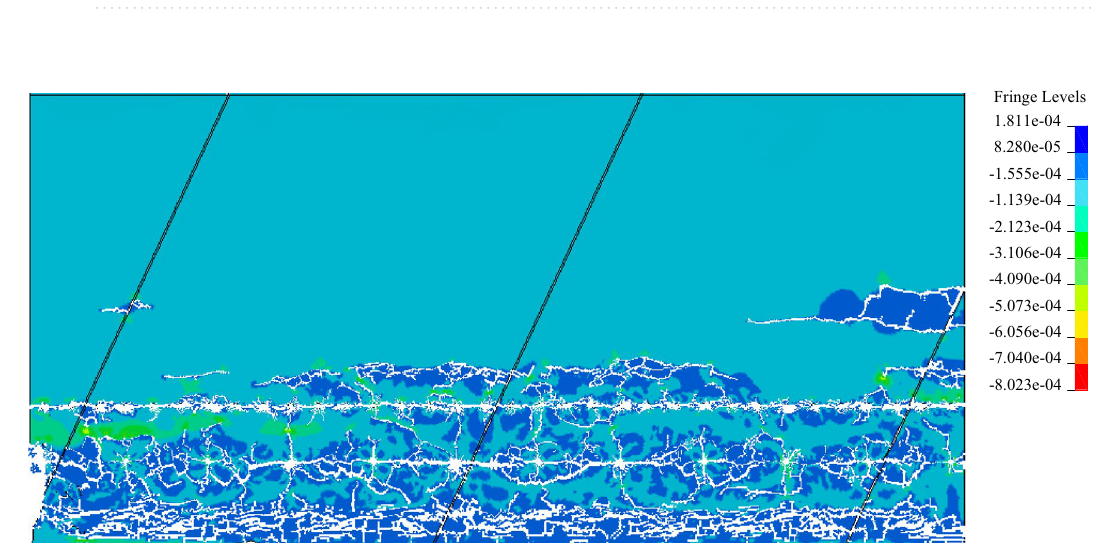
Table 4. Physical and mechanical parameters of the rock and filled joints for calculation.